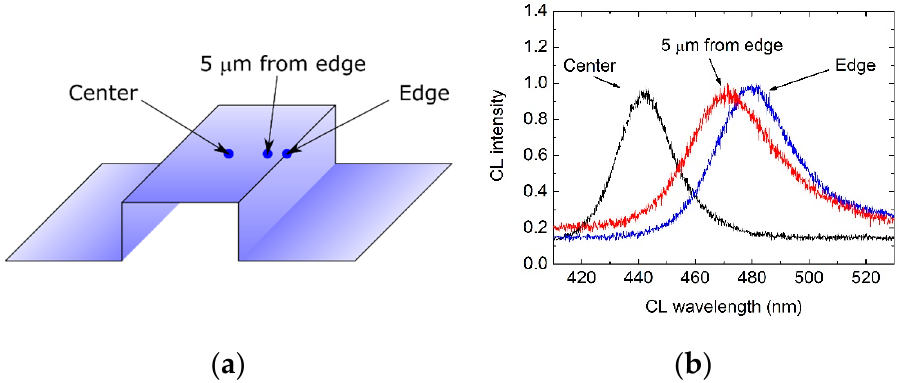
Figure 5. Cathodoluminescence (CL) of the InGaN / GaN structure. Stripe width was 50 µ m. ( a ) Scheme of CL measurement with three characteristic points. ( b ) CL spectra acquired at stripe center, 5 µ m from the stripe edge, and at the stripe edge.